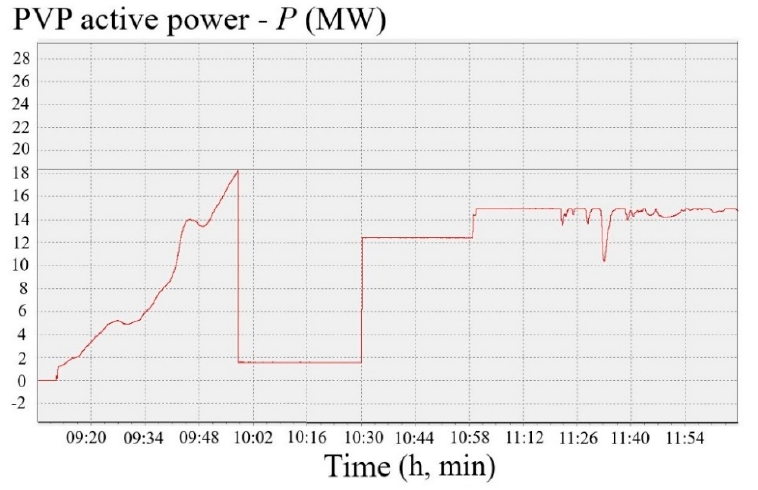
Figure 9. Graph of a frequency change after islanding part of the power system.